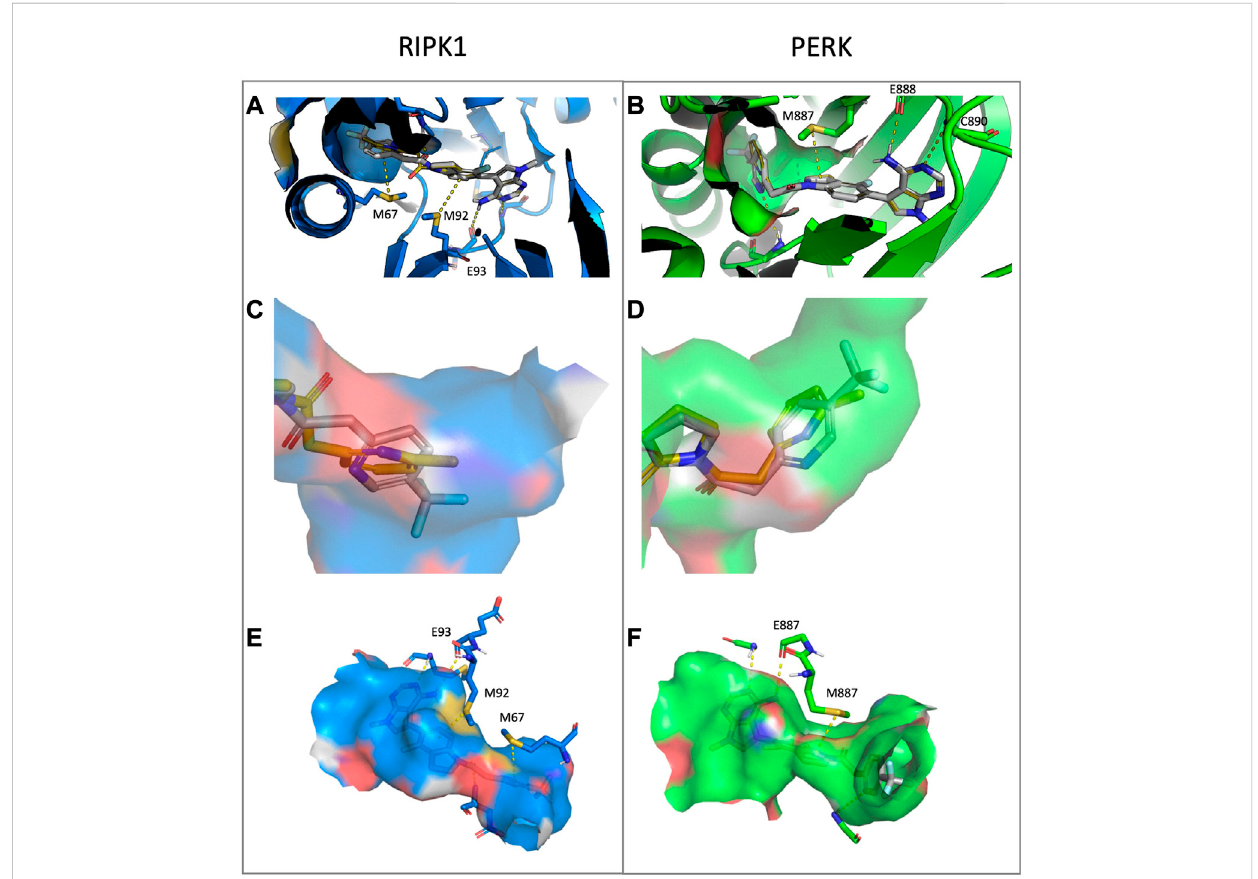
FIGURE 8 Docking of compound UAMC-3861 (grey sticks) and GSK ’ 157 (yellow lines) in RIPK1 (blue) and PERK (green) (A – B) , representation of the allosteric pockets of RIPK1 and PERK with GSK ’ 157 and UAMC-3861 (C – D) and surface representation of the binding pocket for RIPK1 (blue) and PERK (green) and thedifferentinteractionswithUAMC-3861 (E – F) . (A) InRIPK1,UAMC-3861isabletointeractswiththegatekeeperMet92andtendtoformamethionine- aromatic interaction with 4- fl uorindoline ring. (B) In PERK, the tri fl uoromethyl-pyridinyl substituent is surrounded by a less hydrophobic environment. The pyridinyl substituent forms a methionine-aromatic interaction with the gatekeeper Met887. (C) Zoom on the allosteric pocket of RIPK1 where the positions of the pyridinyl moieties of GSK ’ 157 and UAMC-3861 are compared. (D) Zoom on the allosteric pocket of PERK where the differentorientationsofthepyridinylringsarecompared. (E,F) Thetri fl uoromethyl-pyridinyl moiety occupiedadifferentpocketinRIPK1 (E) andPERK (F) . Whileforthelatterthebindingsiteisslightlysolvent-exposed,forRIPK1thepocketisburied,featuringamorehydrophobicpro fi leduetothepresenceof three Leu, two Val, and Met (not shown in